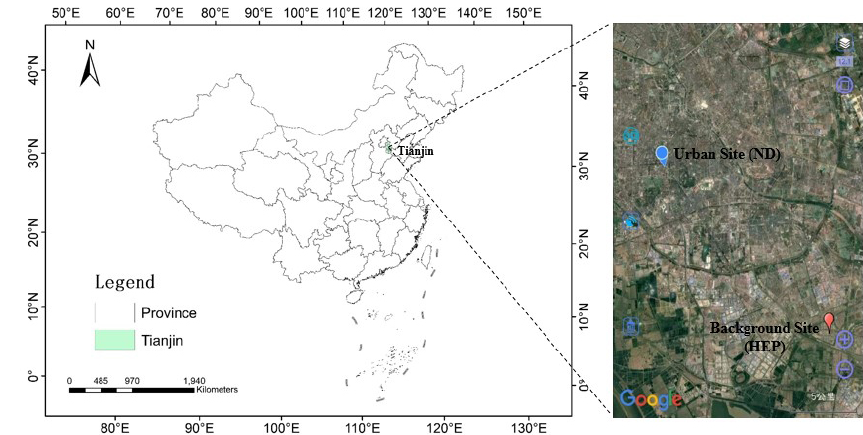
Figure 1. Map of China with the study area, Tianjin, North China. The sampling points located in urban (ND) and suburban (HEP) locations are shown in the inset. (The map in the inset was generated using © Google